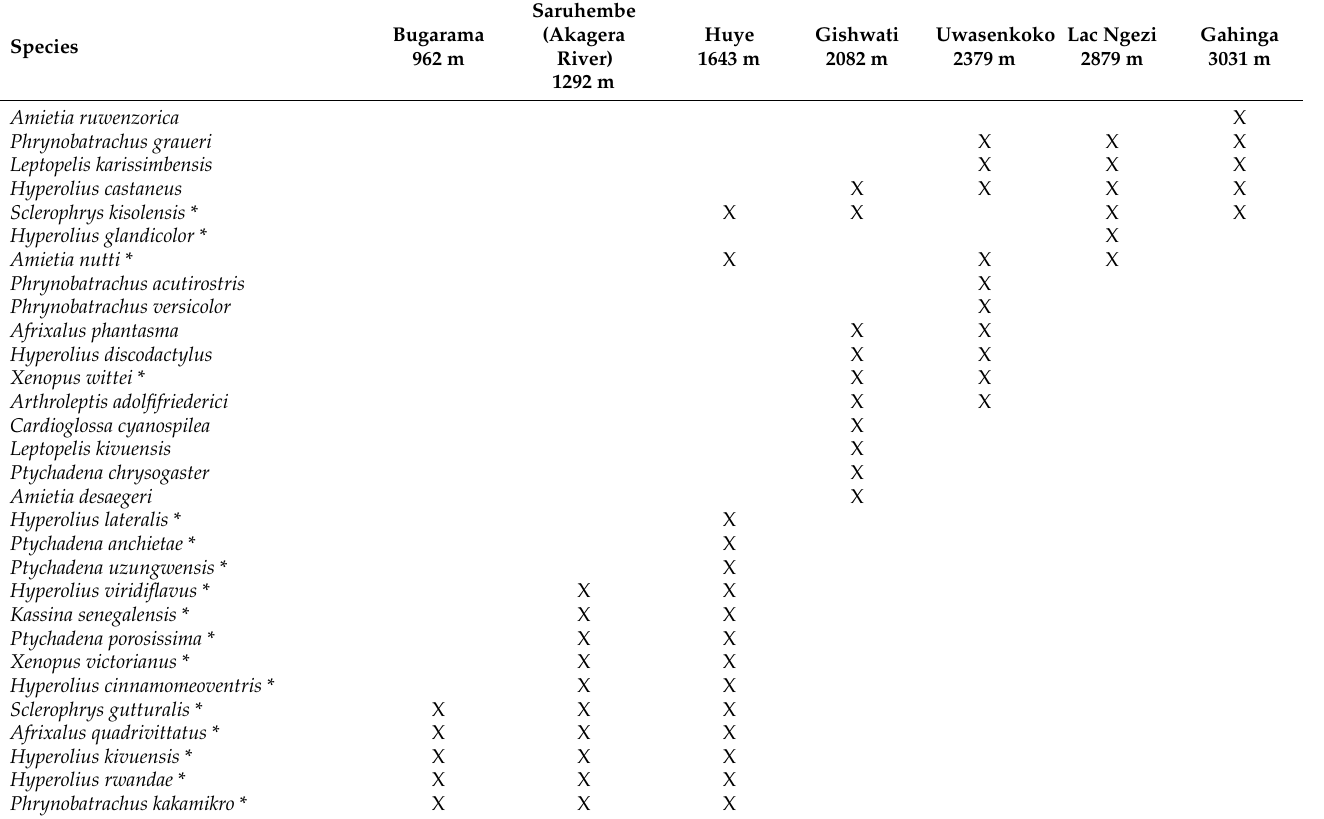
Figure 18. Species richness of amphibian communities along the altitudinal gradient in Rwanda. Table 2. Species composition of seven realized amphibian communities at different elevations in Rwanda. The three sites at lower elevations (962–1643 m) are situated in farmland, the other ones at higher elevations in natural montane forest. An asterisk indicates that the species is tolerant to anthropogenic disturbance.